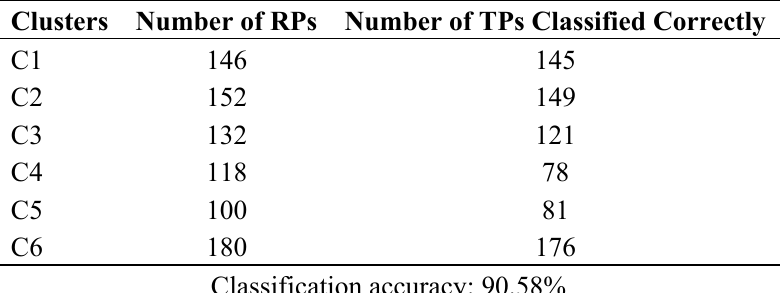
Table 1. Coarse Positioning performance of FCM method.